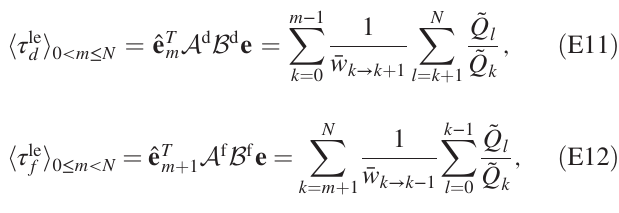
fixed k , it drops out of the sum over f σ